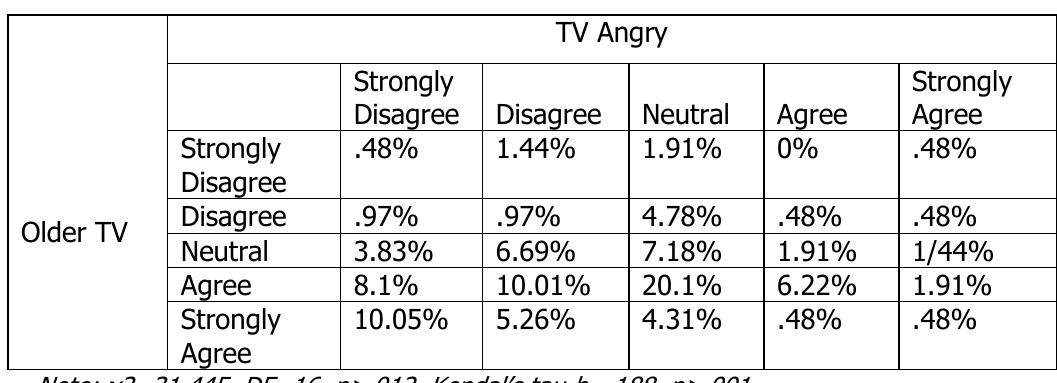
Comparison of the older I get, the more I get used to seeing violence on television and after watching violence on television, it makes me angry Cross